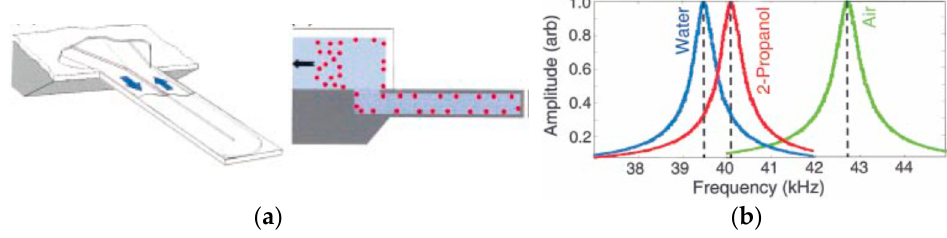
Figure 34. ( a ) Damping in liquid phase resonant mass sensors are reduced by using suspended microfluidic channels as resonators; ( b ) Analytes are detected based on their mass density difference relative to the surrounding solution. [43]. Reproduced with permission from T.P. Burg, Appl. Phys. Lett. ; published by AIP, 2003.